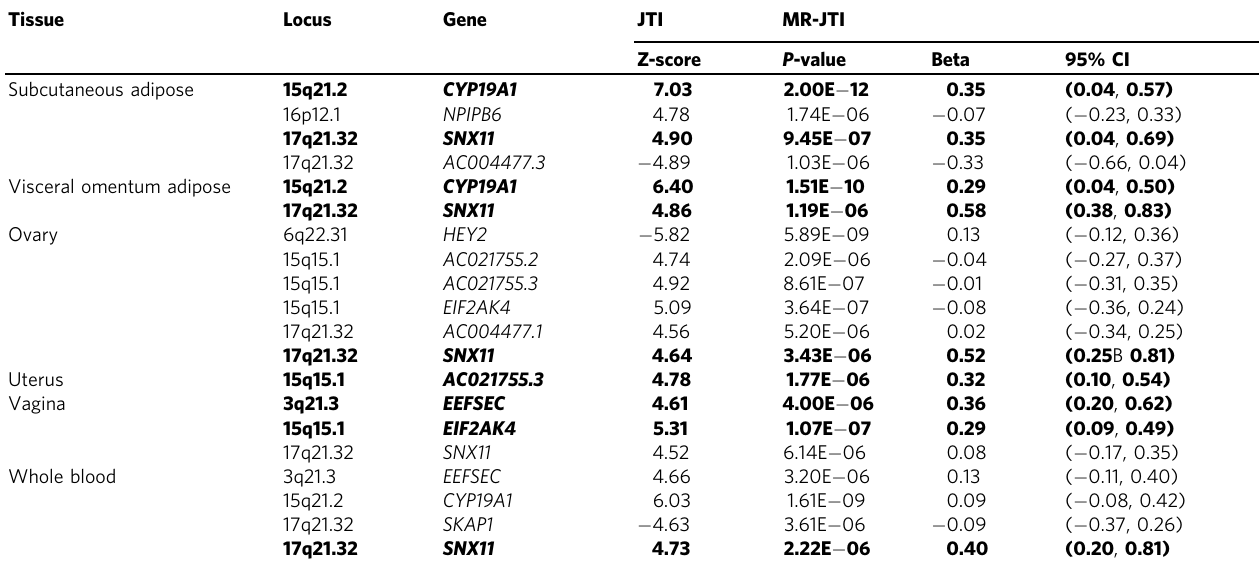
Table 2 Genes associated with endometrial cancer risk as identi fi ed by MR-JTI. Tissue Locus Gene JTI MR-JTI Z-score P -value Beta 95% CI Subcutaneous adipose 15q21.2 CYP19A1